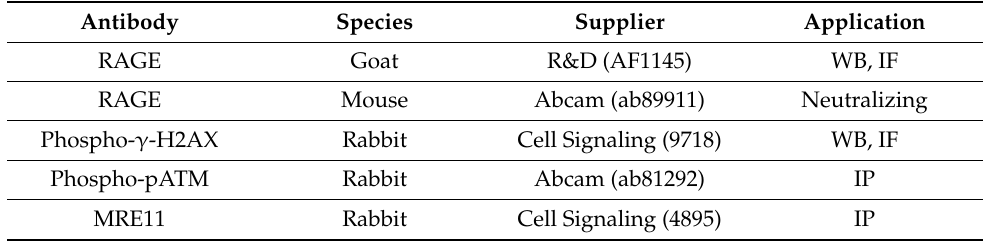
Table 2. List of antibodies used per